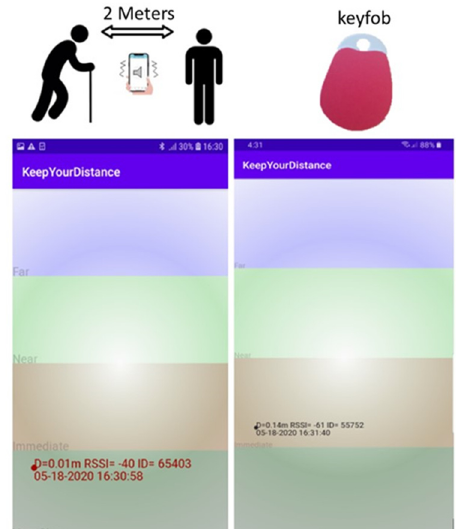
Figure 11. A BLE mobile app and a keyfob concept developed at Nottingham Trent University (NTU) to alert people when they are within 2 m proximity.